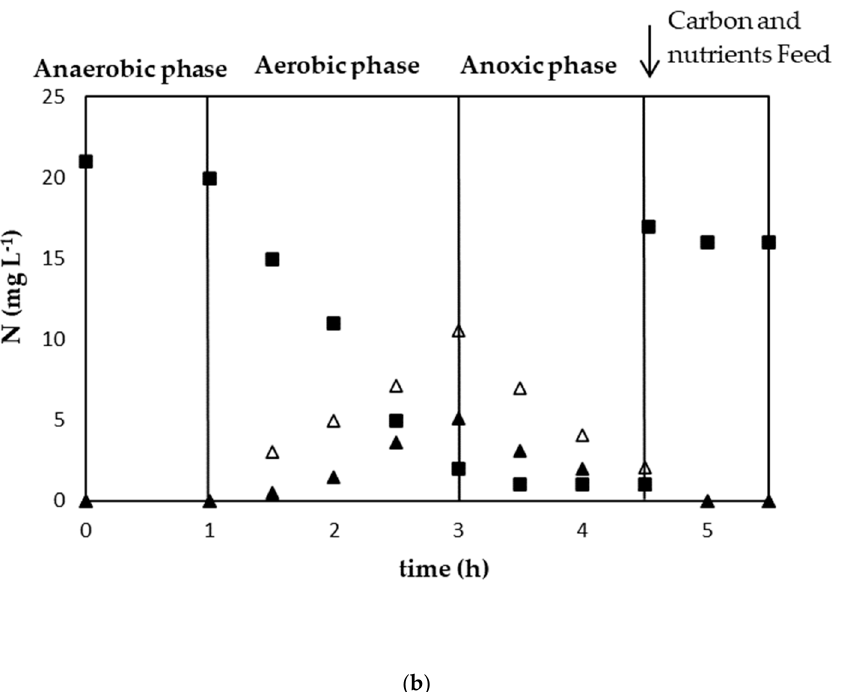
Figure 3. The variation of PO 4 ‐ P ( ● ) and COD ( ○ ) (presented in 2a) and NH 4 ‐ N ( ■ ), NO 2 ‐ N ( ∆ ), and NO 3 ‐ N ( ▲ ) (presented in 2b) during a typical SBR operation cycle .